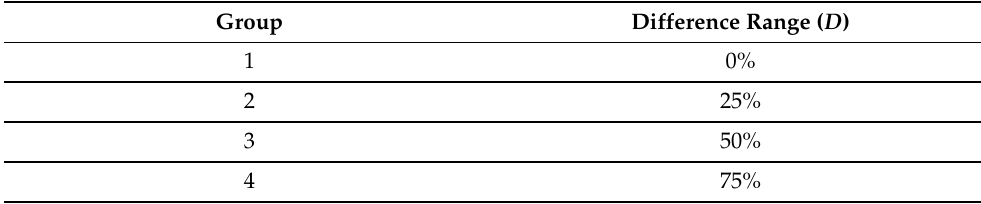
Table 4. The D of each group under different M .